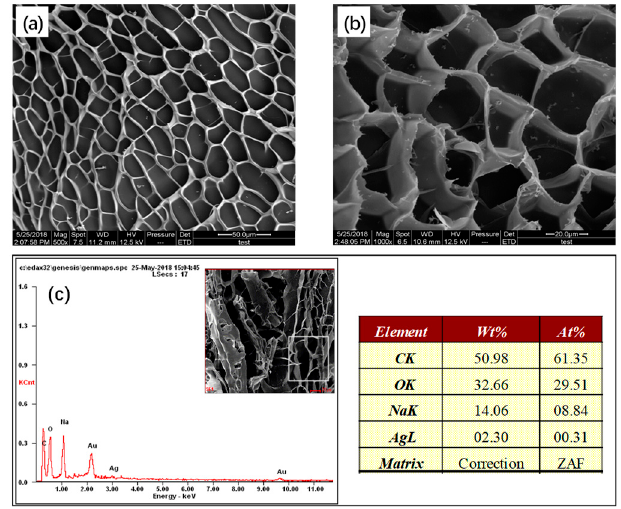
Figure 6. SEM micrographs ( a ) 500×, ( b ) 1000× and EDS ( c ) of Z3.